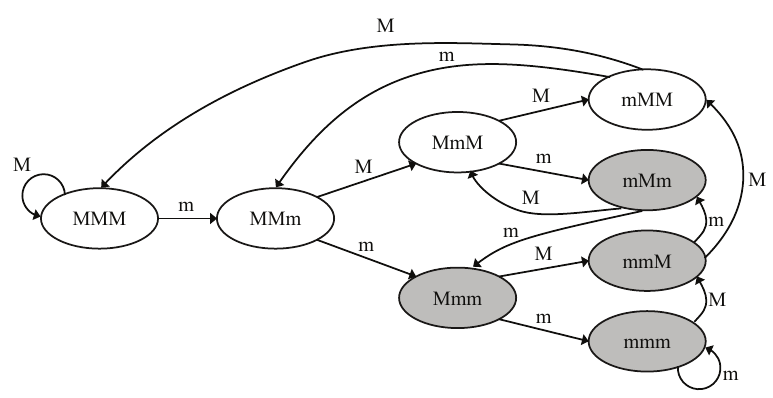
Figure 1. State transition diagram example of (2,3)-firm [6] where M and m represent deadline meet and miss,